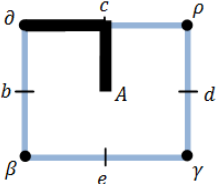
Figure 6 . Example of corresponding entities to dimensional cell: A(node) = 0-cell, B(edge) = 1-cell, C(face) = 2-cell, and D(solid) =